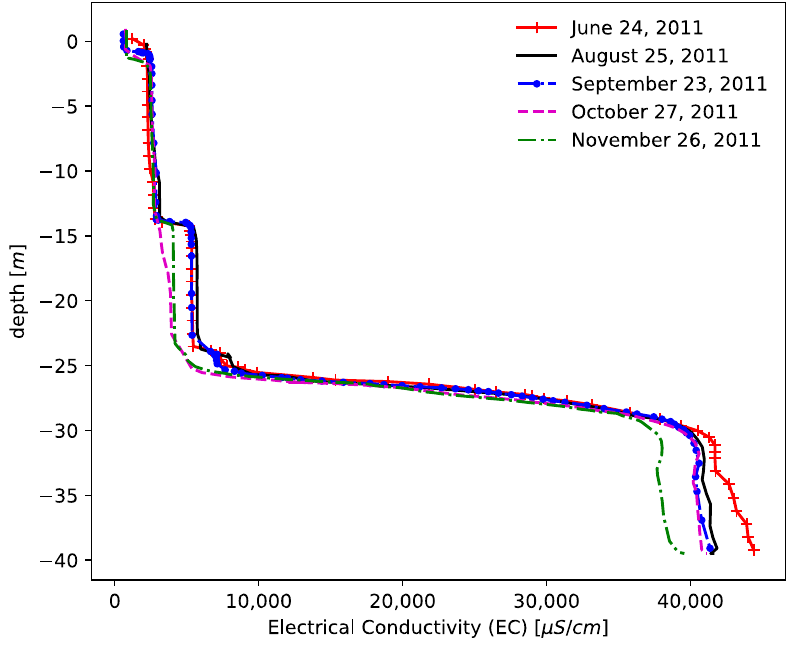
Figure 2. Electrical Conductivity (EC) variation with depth in “well 18” [21].